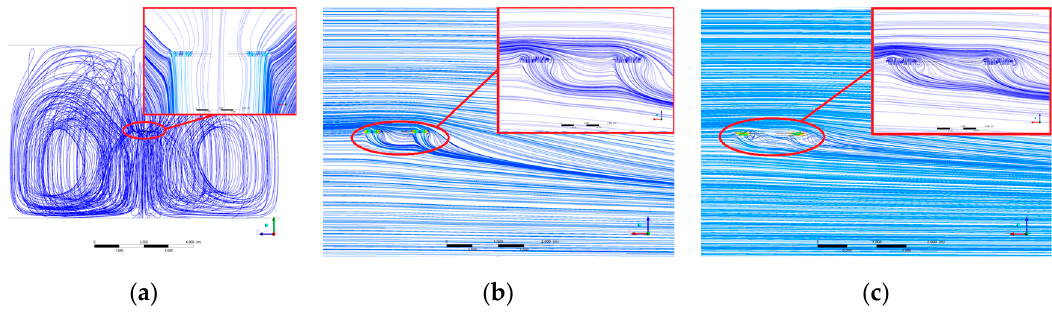
Figure 8. Streamline distribution ( a ) 0 m/s ( b ) 2.5 m/s ( c ) 4 m/s.